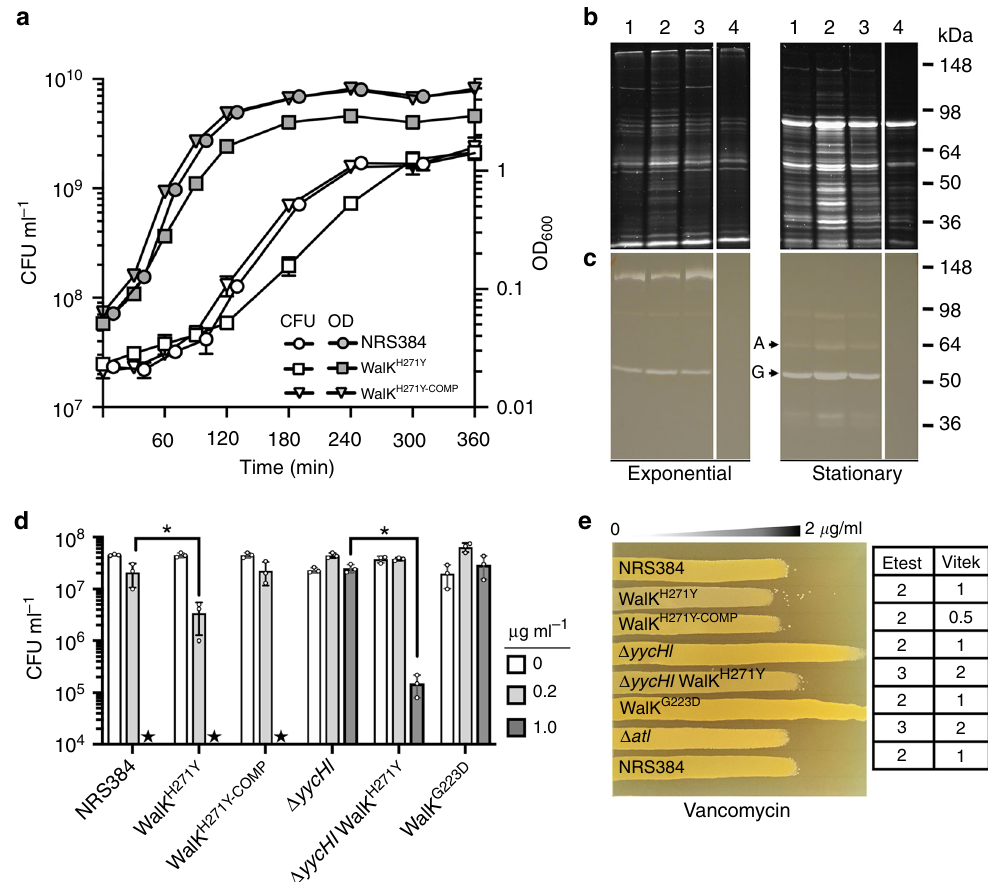
Fig. 2 Phenotypic impact of WalK H271Y mutation on S. aureus . a Growth kinetics of the WalK H271Y mutant compared to the wild-type (WT) and complemented strains. Overnight cultures were diluted 1:100 into fresh and grown at 37 °C (200 rpm). The cultures were sampled at the indicated time points for OD 600 and colony-forming unit (CFU) readings. The WalK H271Y strain exhibited altered growth kinetics compared to the WT and complemented strains, with the loss of a lag phase and a subsequent reduction in doubling time during exponential growth. Error bars indicate standard deviation (s.d.) from three biological replicates. b Analysis of the total exoproteome and Atl secretion. Supernatant proteins from exponential or stationary phase cultures were run on 10% sodium dodecyl sulfate-polyacrylamide gel electrophoresis gels for SYPRO Ruby staining or c zymogram analysis through the incorporation of 1.5% Micrococcus luteus cells. The lane contents are: (1) NRS384, (2) WalK H271Y , (3) WalK H271Y-COMP , and (4) Δ atl , with ‘ A ’ and ‘ G ’ representing amidase and glucosaminidase, respectively. The protein pro fi le of an atl mutant was included as a control for Atl activity. d Impact of the mutations on the sensitivity to lysostaphin. Star denotes ‘ below the limit of detection ’ (10 3 CFU ml − 1 ). Depicted are the data points, mean and s.d. of triplicate biological experiments. The null hypothesis (no difference in mean lysostaphin sensitivity between WT and WalK H271Y at 0.2 µ g ml − 1 or Δ yycHI and Δ yycHI WalK H271Y at 1 µ g ml − 1 ) was rejected for P < 0.05* (unpaired, Student ’ s t test). e Impact on vancomycin sensitivity. Agar plates were made